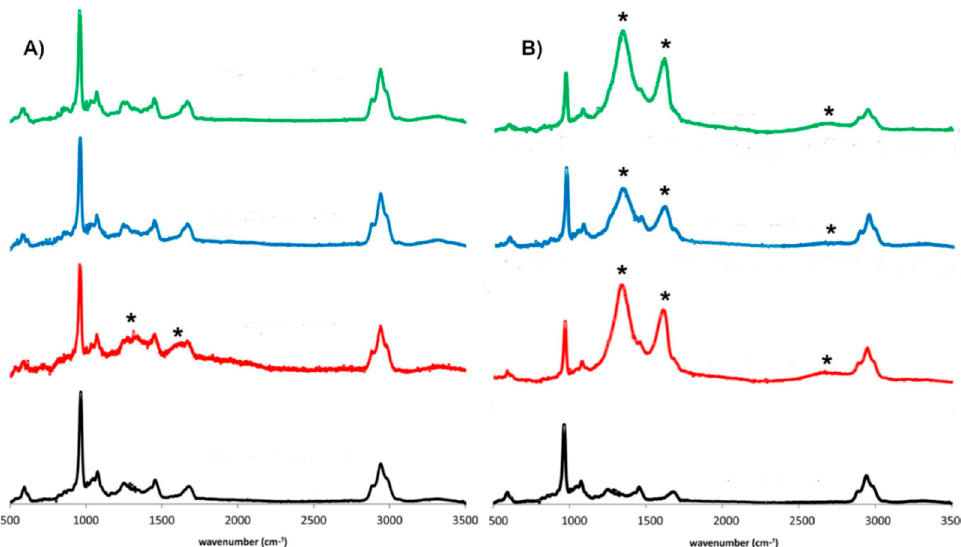
Figure 2. Raman spectroscopy of collagenated blocks coated with graphene-oxide (G-N) at concentrations of ( A ) 2 (G-N2) and ( B ) 10 μ g/ml (G-N10). The black spectra correspond to the uncoated bone block. The red, blue, and green spectra correspond to spectra recorded in three different points of the G samples. The Y-axis represents Raman intensity in arbitrary units, whereas * refers to recognized graphitic material bands (i.e., the G band at 1580, the D band at 1350, and the 2690 cm − 1 ).